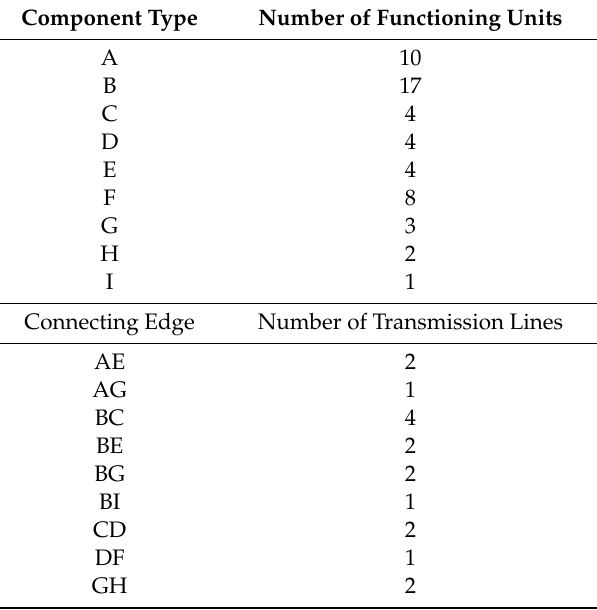
Figure 2. Network Model of Electric Substation. Table 1. Electric Substation Functioning Unit Layout (according to site layout map).